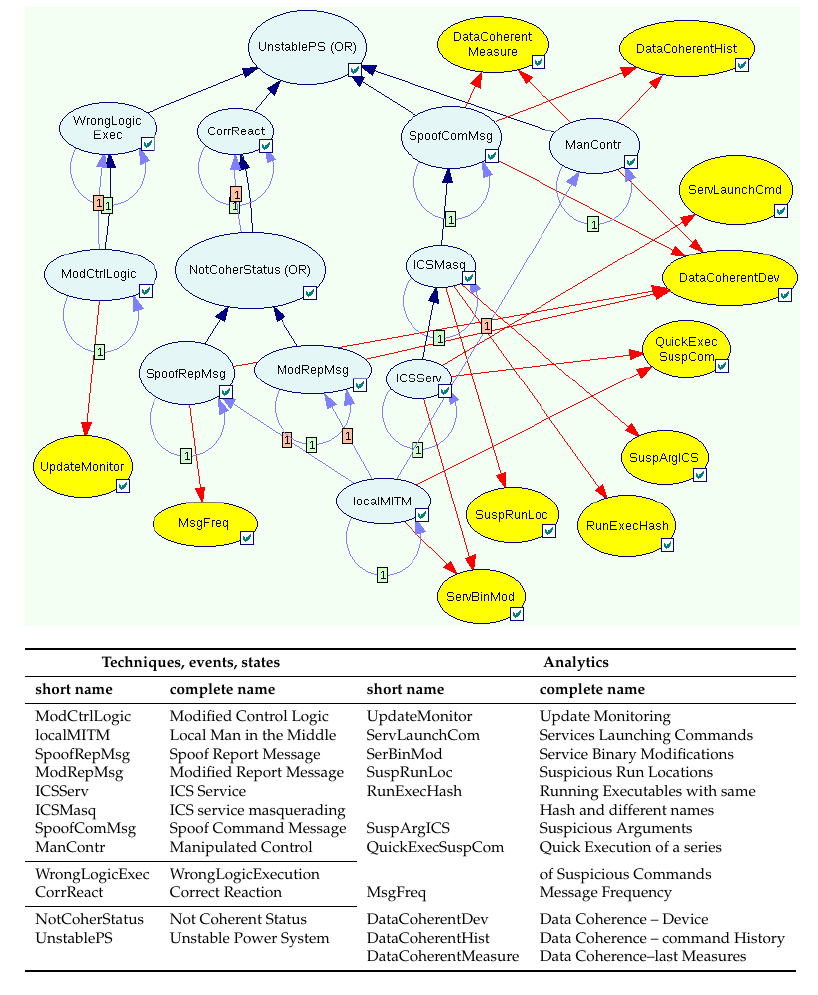
Figure 4. DBN model of ICS